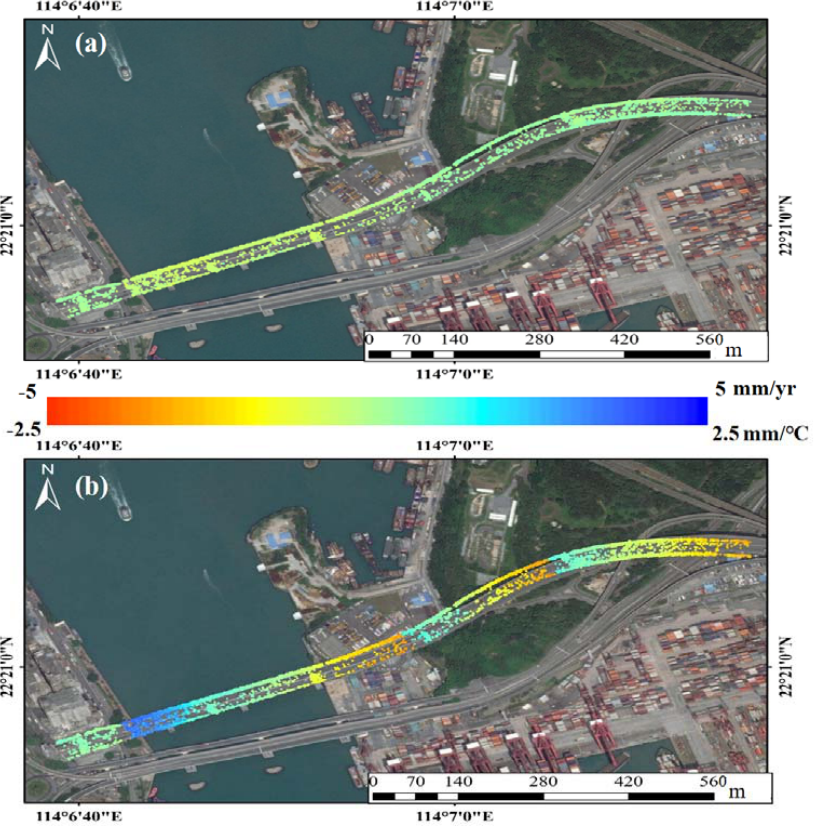
Figure 17. The ( a ) trend deformation and ( b ) thermal dilation of the TKH.